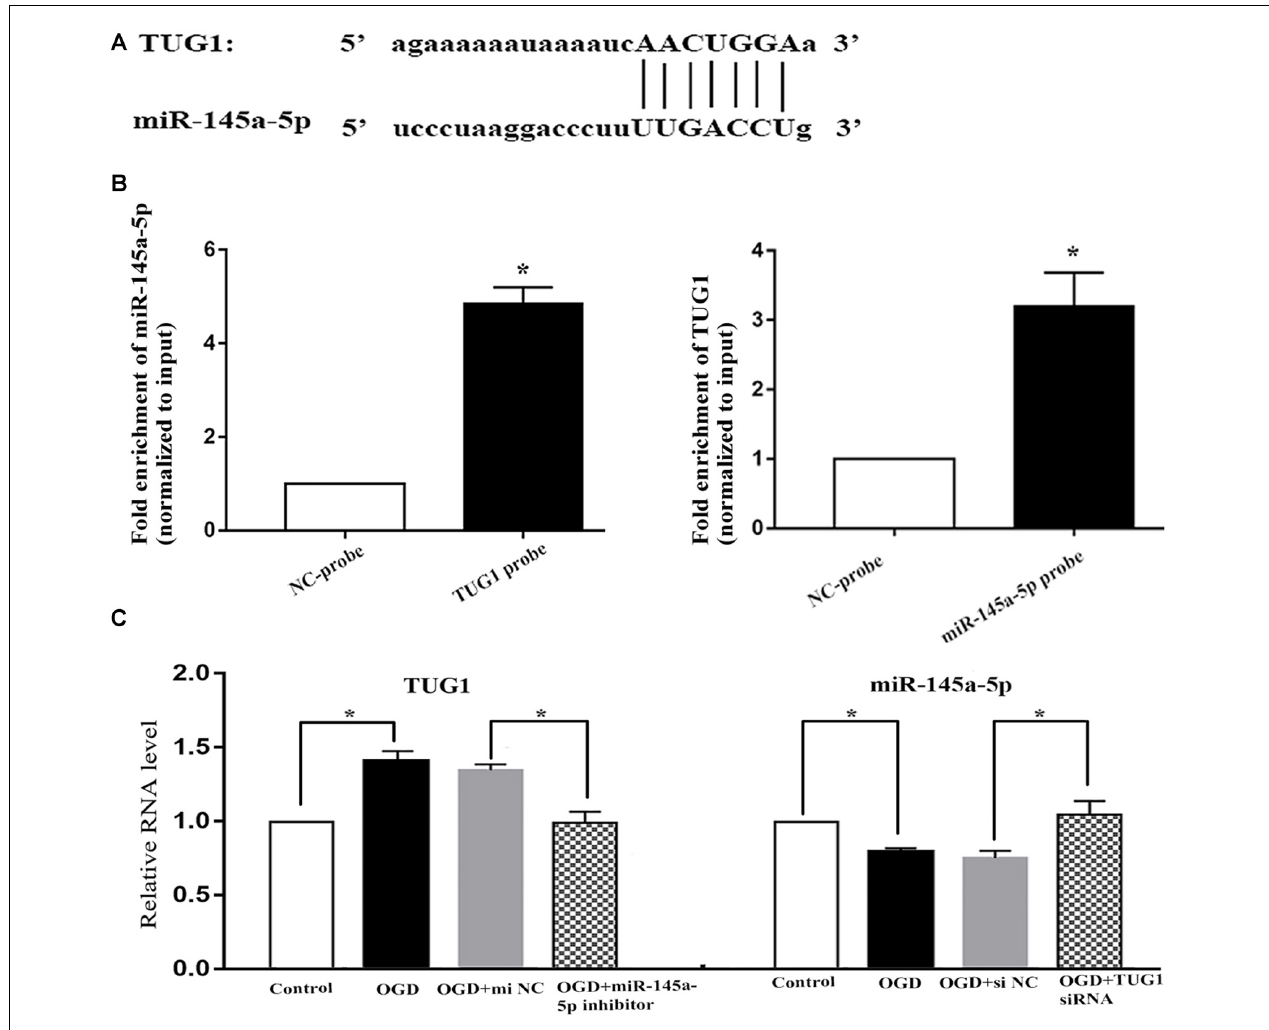
FIGURE 2 | Correlation between TUG1 and miR-145a-5p. (A) Putative binding sites revealed by bioinformatics analysis. (B) Direct binding further confirmed by biotin-labeled RNA-RNA pull-down assay. (C) Quantification of RNAs by qRT-PCR. OGD-induced up-regulation of TUG1 was sufficiently turned over